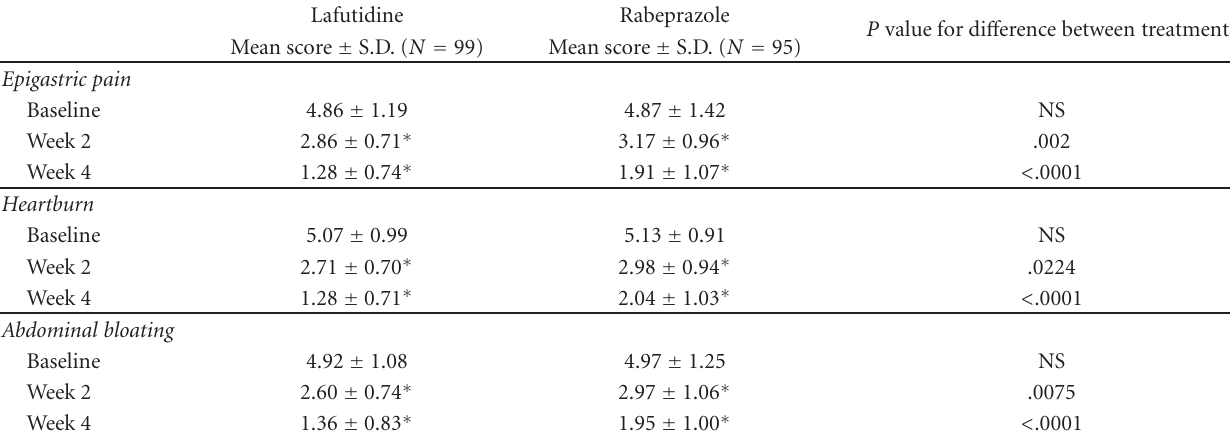
Table 3: Symptom score (Mean ± SD) at baseline and after 2 and 4 weeks. Rabeprazole P value for di ff erence between treatments Mean score ± S.D. ( N = 99)